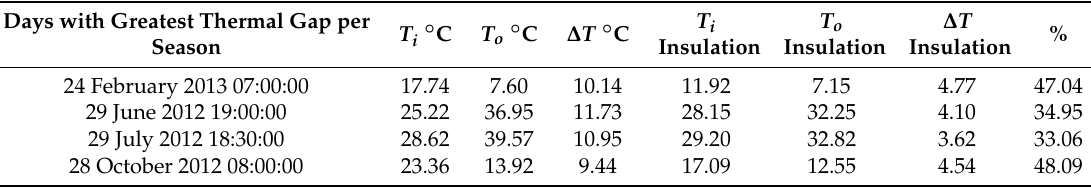
Table 9. Results of T i − T o of the insulation layer during the greatest thermal gaps per climate season. Percentage according to total thermal